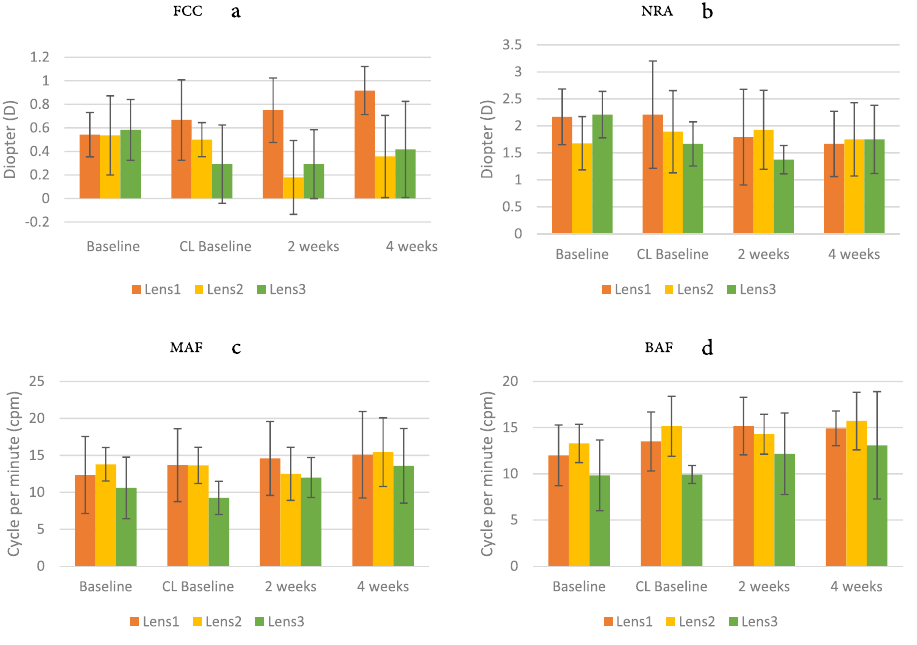
Figure 4. ( a ) Fused cross cylindrical (FCC) lens measurement; ( b ) negative relative accommodation(NRA); ( c ) MAF; ( d ) BAF performance on Groups × Measurements; error bars represent the standard